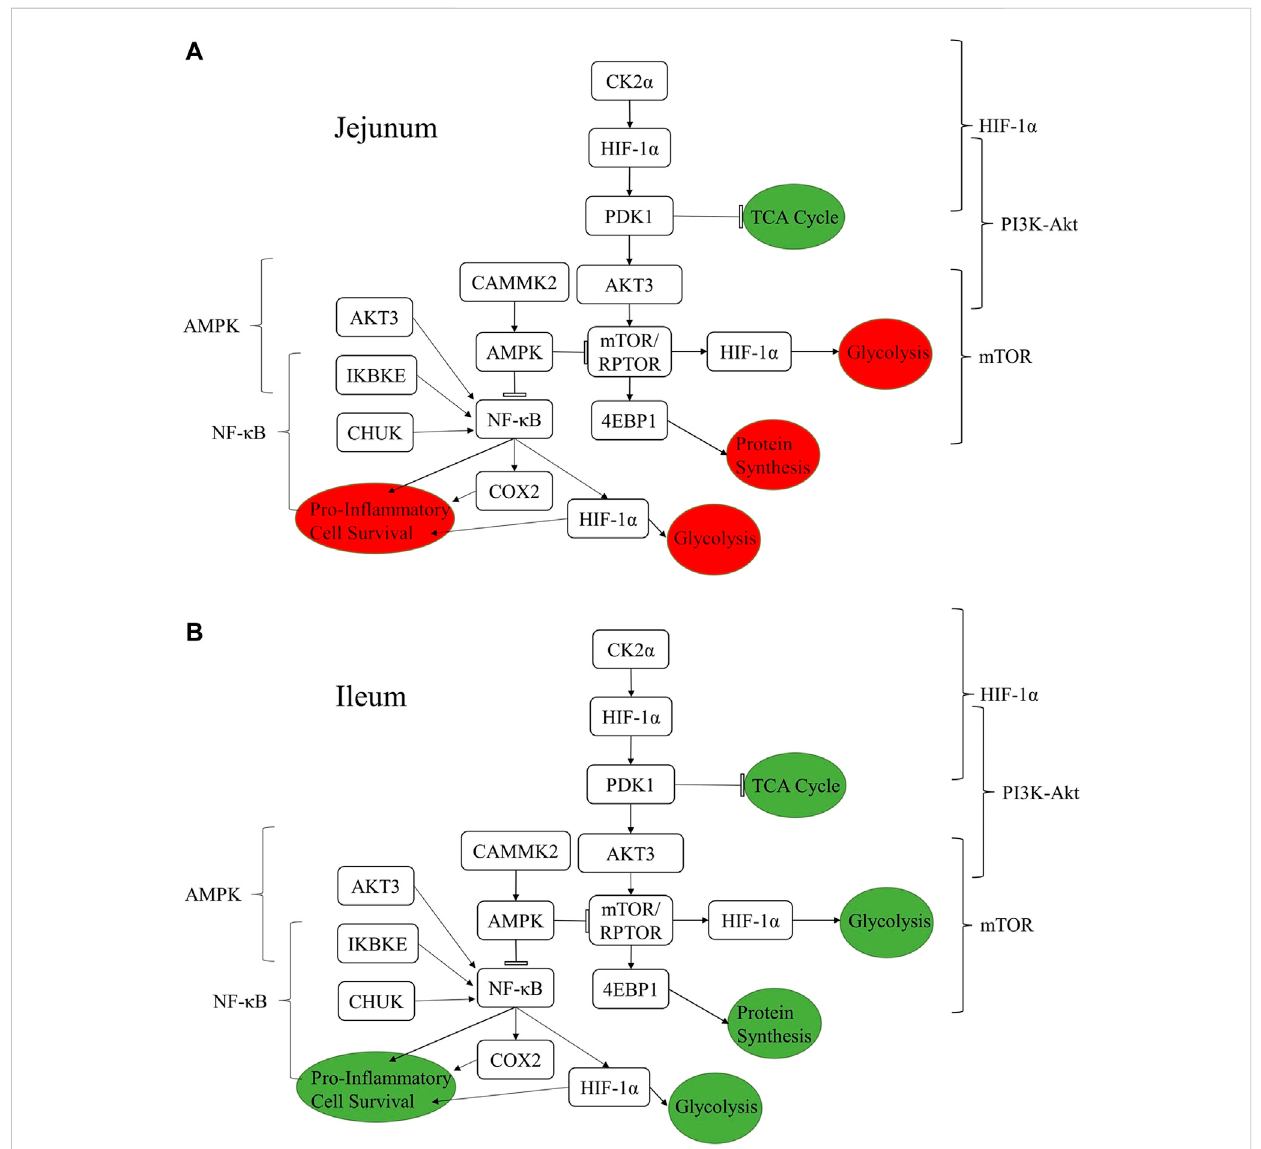
FIGURE 4 Summary fi gureshowingtherelationshipsbetweenproteinsdiscussedintheresultsandtheresultingfunctionalchangesimpartedbytheproductin jejunum (A) and ileum (B) . The brackets on either side of the fi gure denote the relevant signaling pathway. The colored circles represent the downstream functional effects of the signaling represented. The colors of the circles show whether the downstream functional effect is increased (green) or decreased